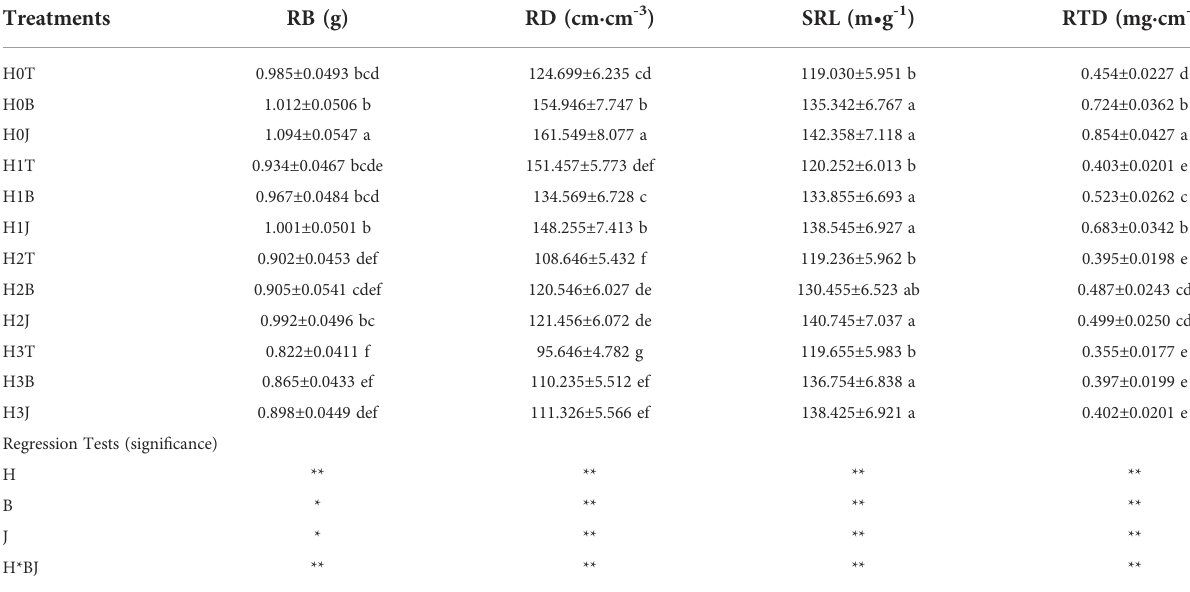
TABLE 3 Cotton root structure in different